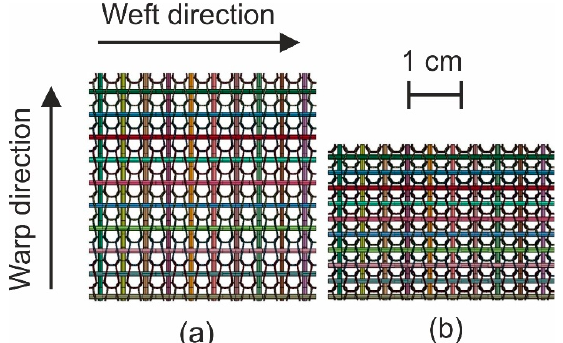
Figure 8. Comparison of the meso-scale models of the two fabric variants with 10 warp and 10 weft reinforcing yarns on the same scale, both variants share the same pattern but with different density (compare with Figure 5): ( a ) Variant 1; ( b ) variant 2.